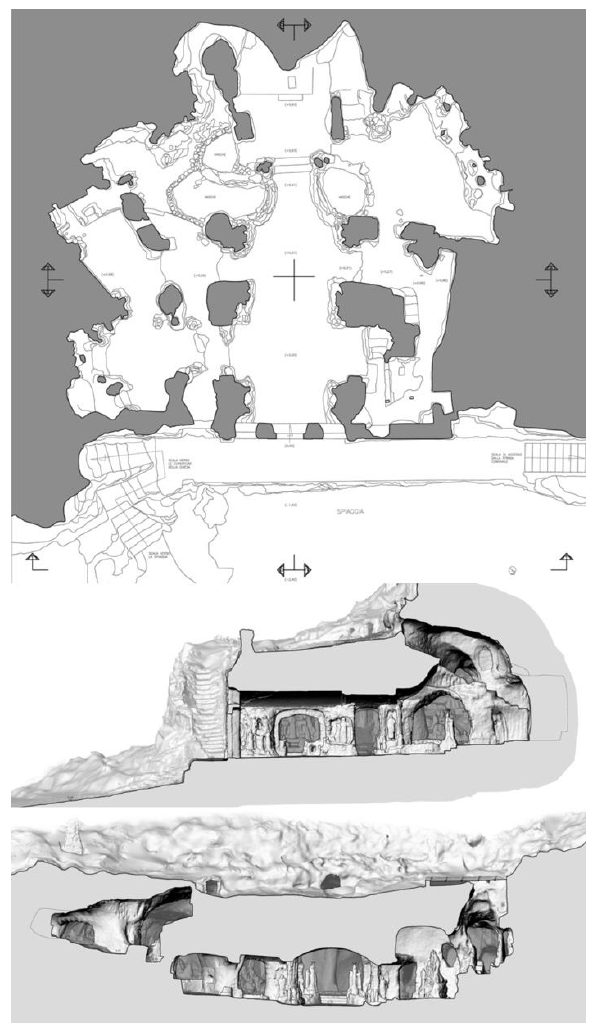
Figure 1. Two-dimensional representations of the